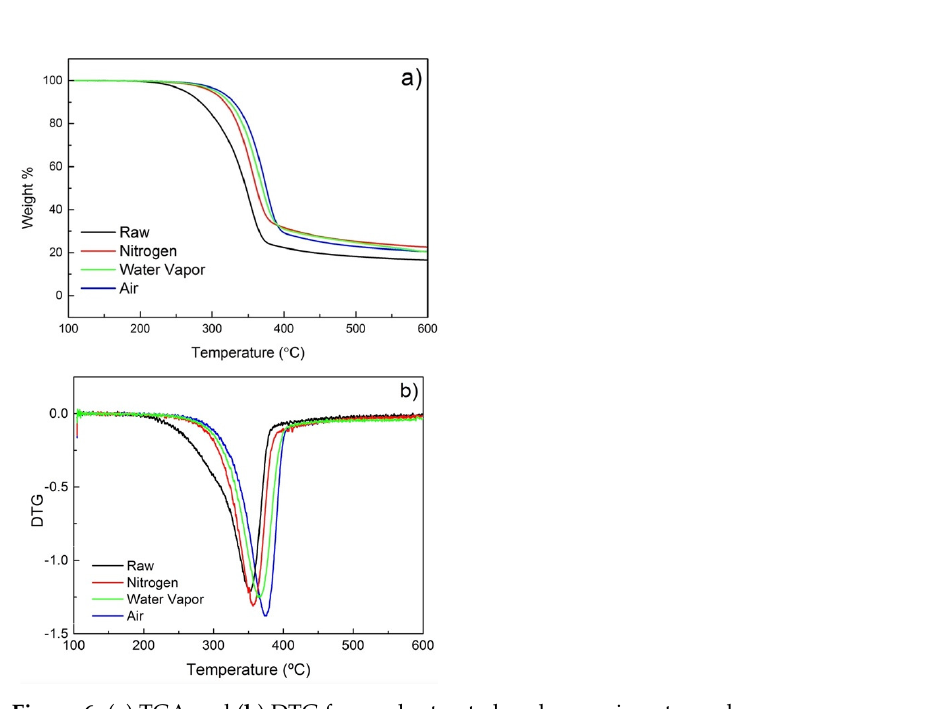
Figure 5. ( a ) TGA and ( b ) DTG for poplar treated at reduced pressures.